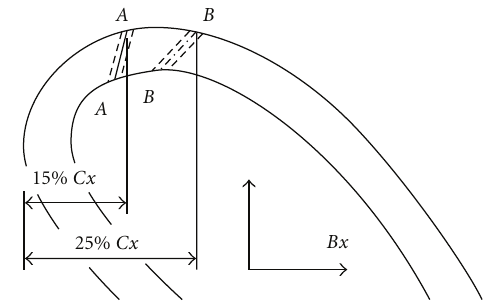
Figure 23: Film-cooling hole locations, for cambered vanes with film cooling